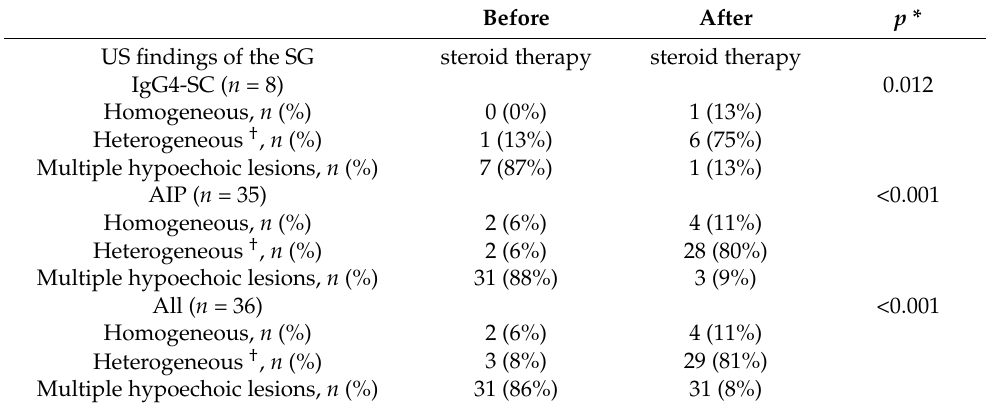
Table 2. Ultrasonography findings of the submandibular glands before and after steroid